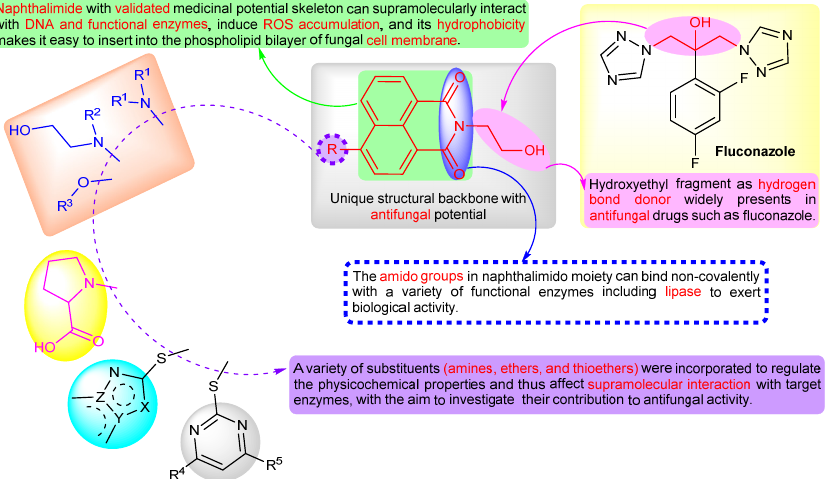
Figure 1. Design of functionalized hydroxyethyl naphthalimides by structural modification.